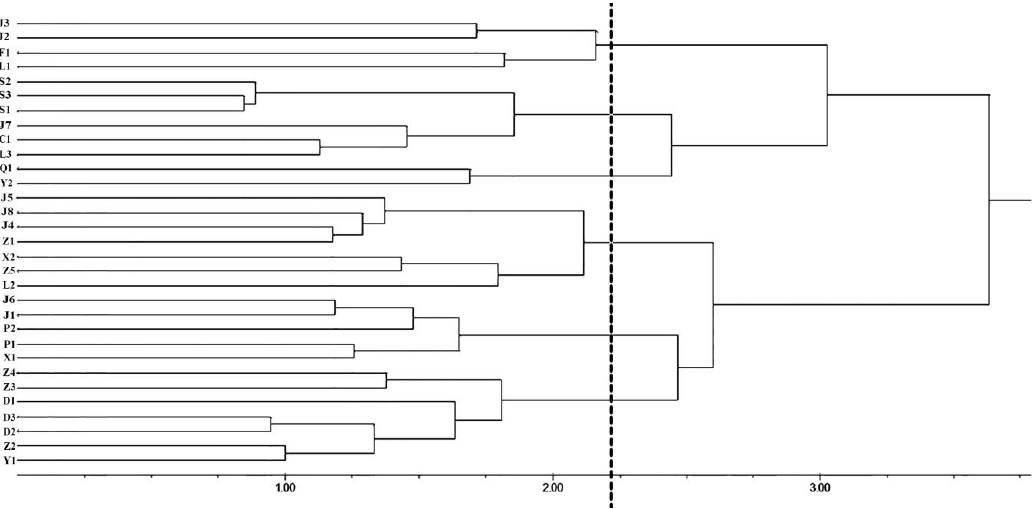
Figure 3. Clustering analysis of H. acerba germplasm resources. Table 7. Analysis of quality traits of H. acerba germplasm resources in different